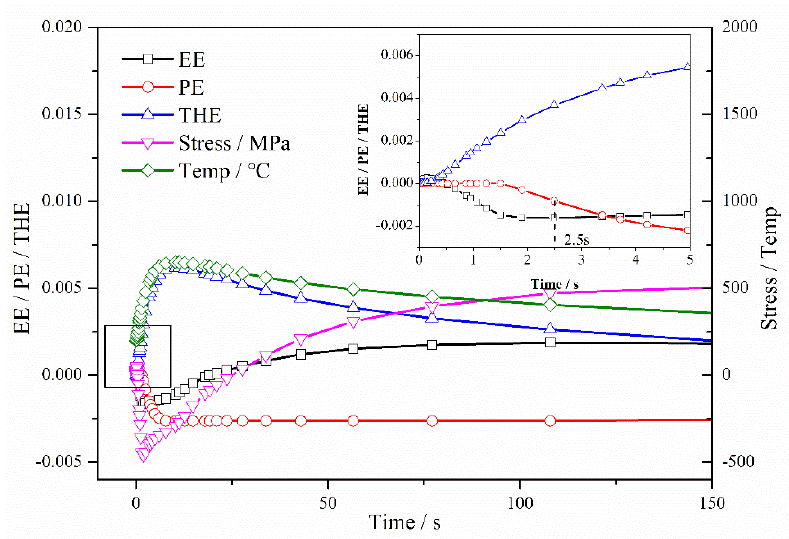
Figure 13. Temperature, strain, and WRS evolution in first half of cooling for element in cladding layer at −6.5 mm (EE, elastic strain; PE, plastic strain; THE, thermal strain; Stress, WRS; Temp, temperature).